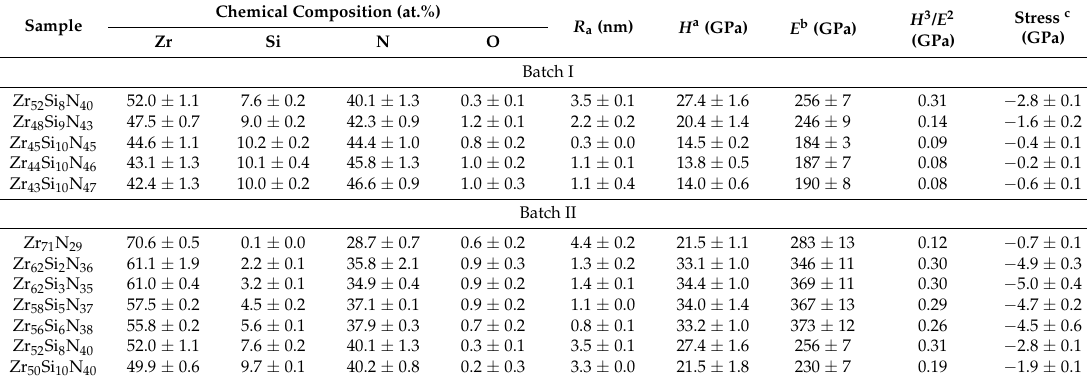
Table 2. Chemical compositions, surface roughness, mechanical properties and residual stress values of Zr–Si–N films.